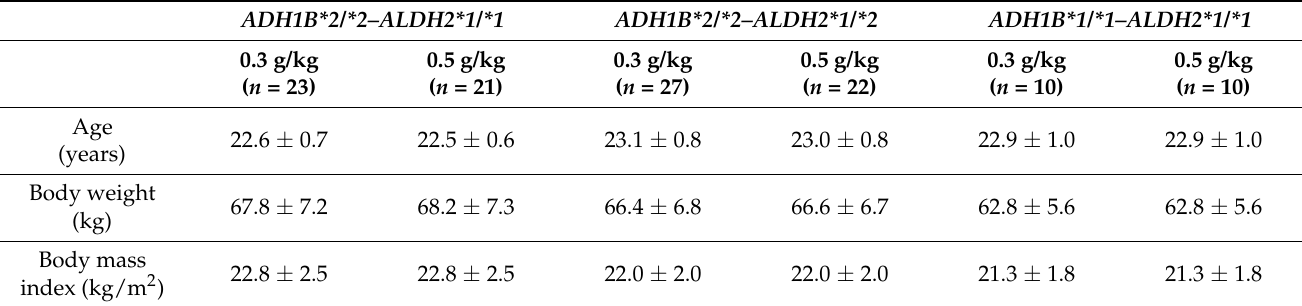
Table 1. Characteristics of individuals with different ADH1B and ALDH2 genotypes for subjective response study.